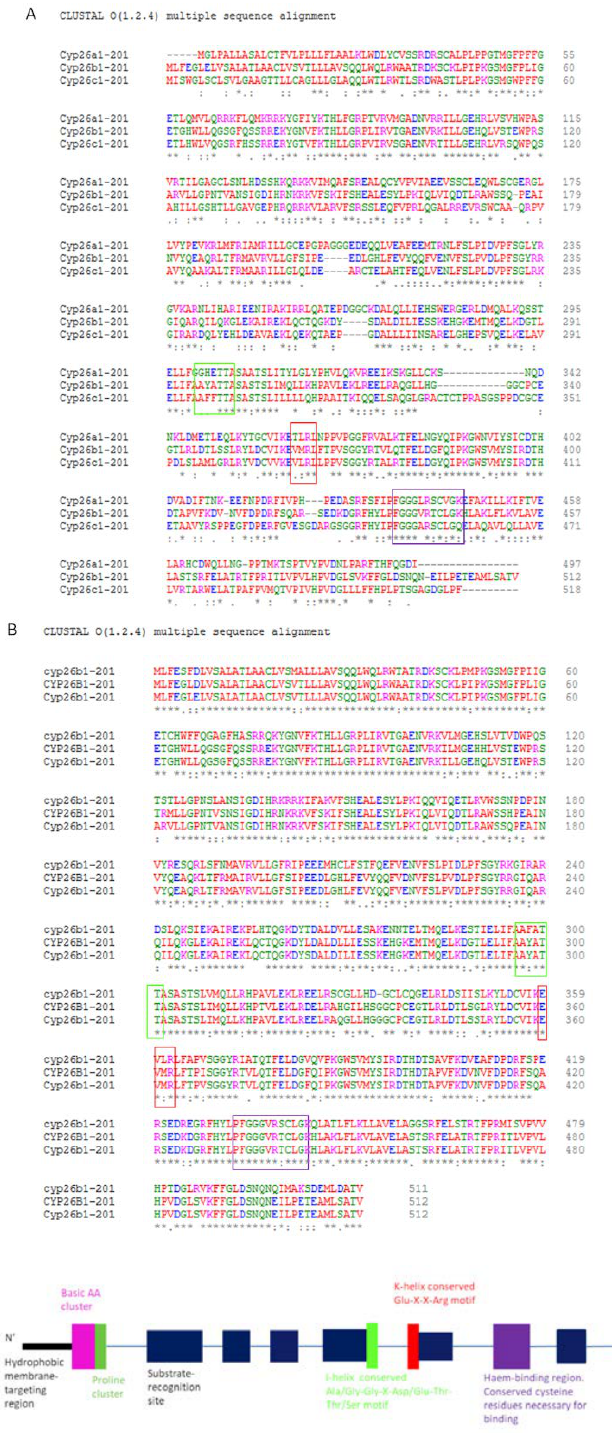
Figure 3. CYP26 protein amino acid sequences and protein schematic. ( A ). Clustal Omega alignment of mouse CYP26A1, B1 and C1 amino acid sequences showing the relatively low level of sequence conservation between the family members. ( B ). Clustal Omega alignment of amino acid sequence of CYP26B1 between zebrafish, mouse and human showing a high degree of conservation between species. ( C ). Schematic of CYP26 protein structure with conserved I (green box) and K (red box) helix regions and the conserved haem-binding domain (purple box). Same colour boxes denote these regions in ( A ). and ( B ).